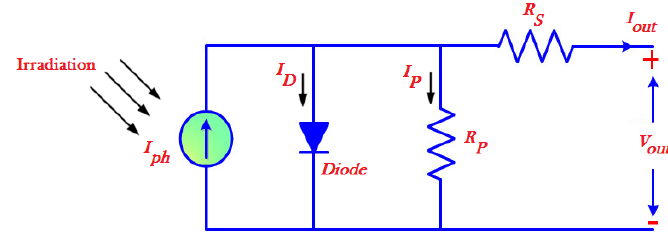
Figure 2. Simplest single diode PV module equivalent circuit.